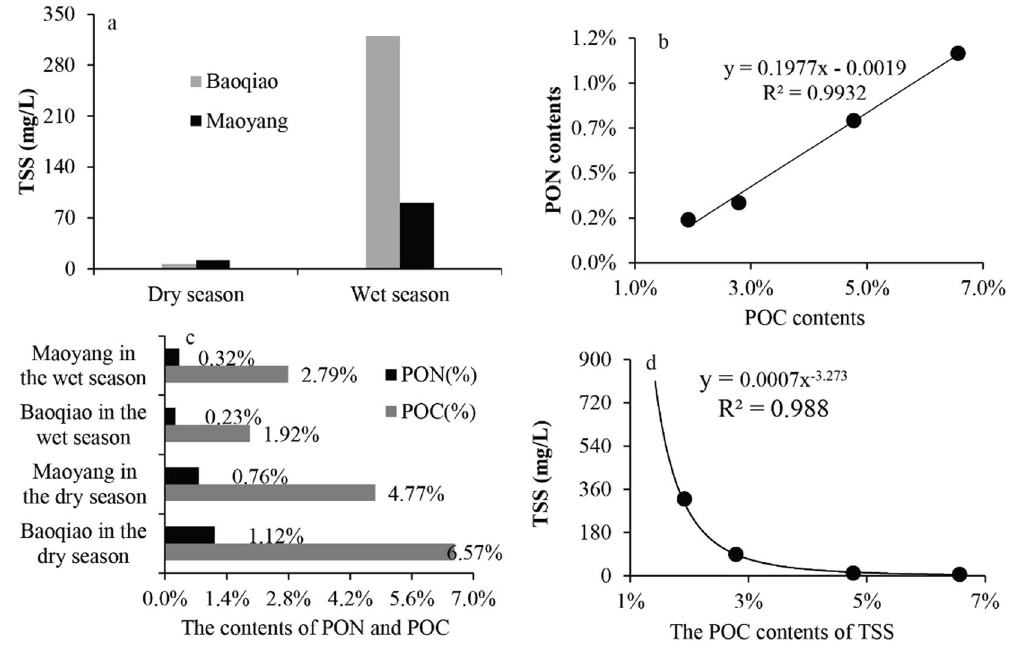
Figure 4. The contents and correlations of TSS, PON, POC in